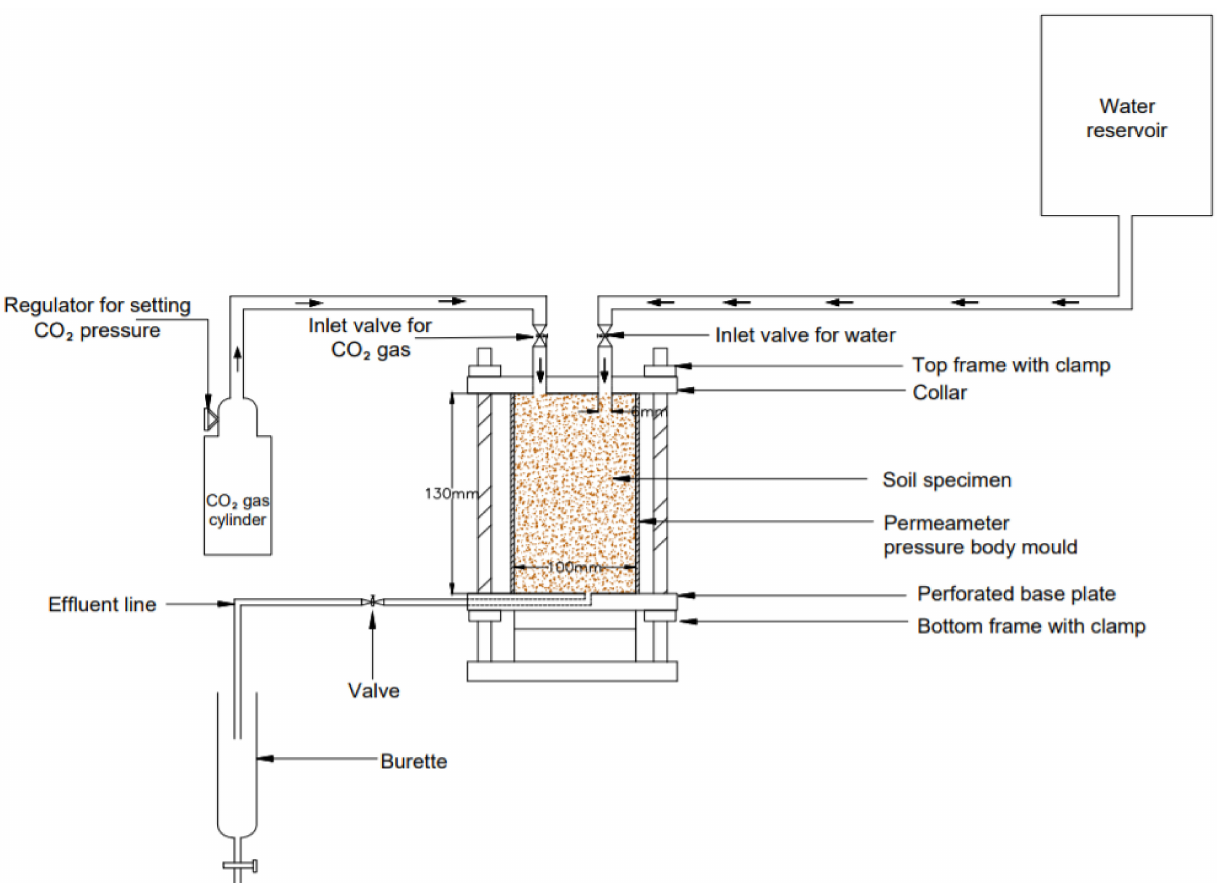
Figure 2. Schematic diagram of the hydraulic conductivity test setup and carbonation. Duplicate tests were conducted on each specimen, and the average hydraulic conduc- tivity was reported. Hydraulic conductivity tests were also conducted on uncarbonated- treated specimens (10%, 20%, and 30% olivine content) after 3, 7, and 14 days curing duration. Using Equation (3), the hydraulic conductivity was calculated.